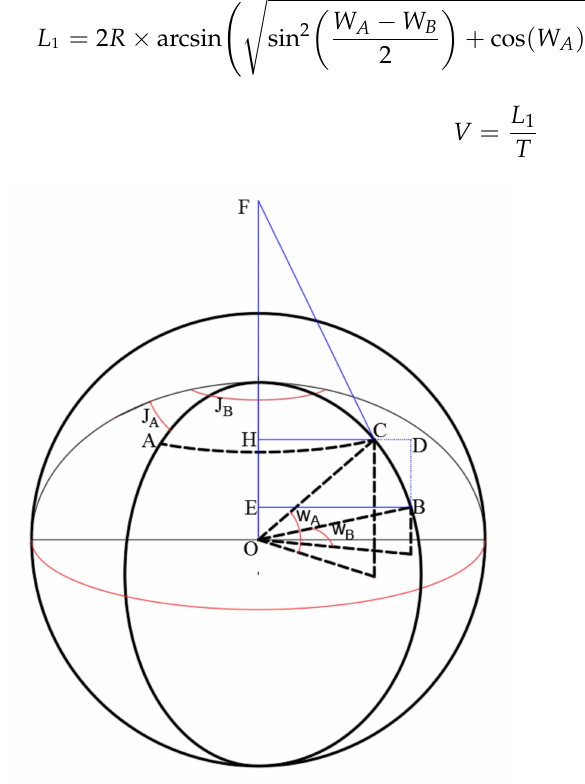
Figure 4. Analytic map of latitude and